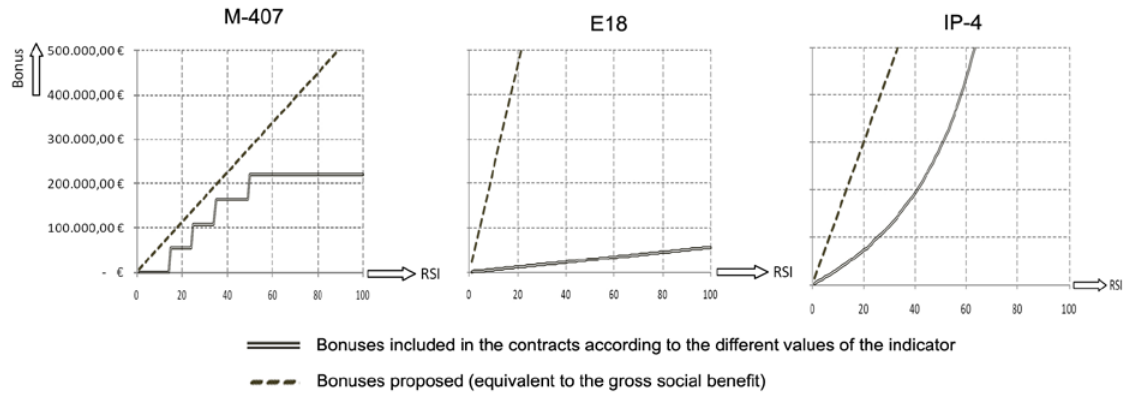
Figure 6. Comparison of the road safety bonuses and the social benefits derived from the different values of the road safety indicators for the three selected concession contracts Table 4. Bonuses included in three concessions vs. the safety benefit for some values of the